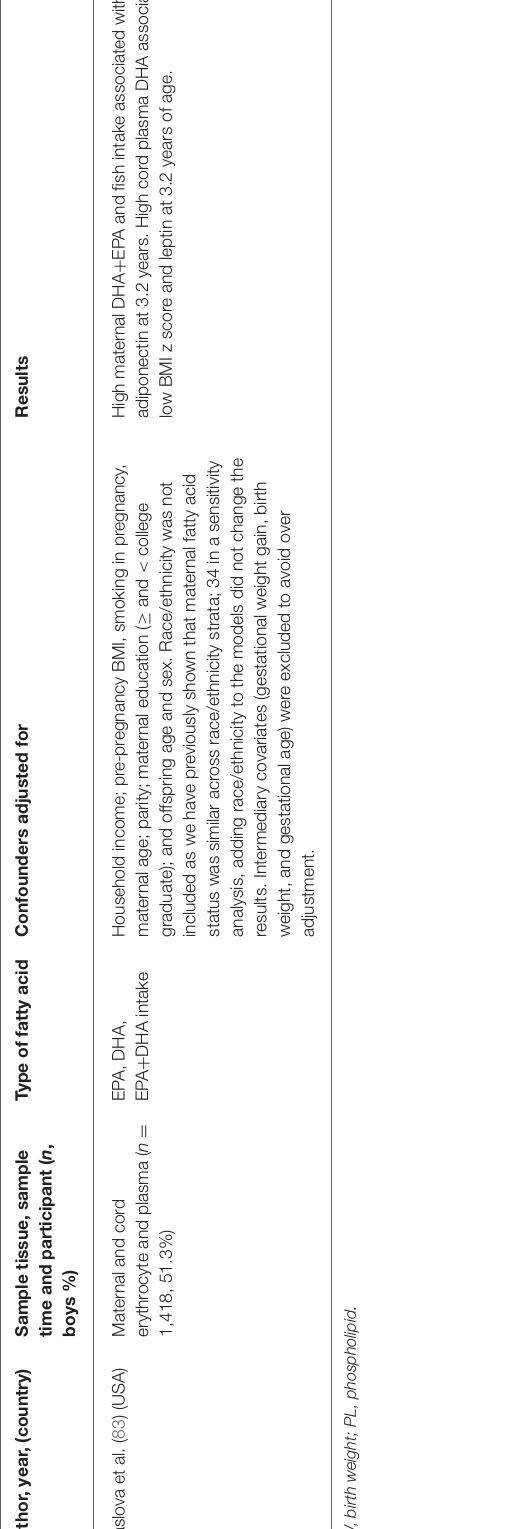
TABLE 5 | Summary of outcomes and fatty acids for all 14 included observational studies.